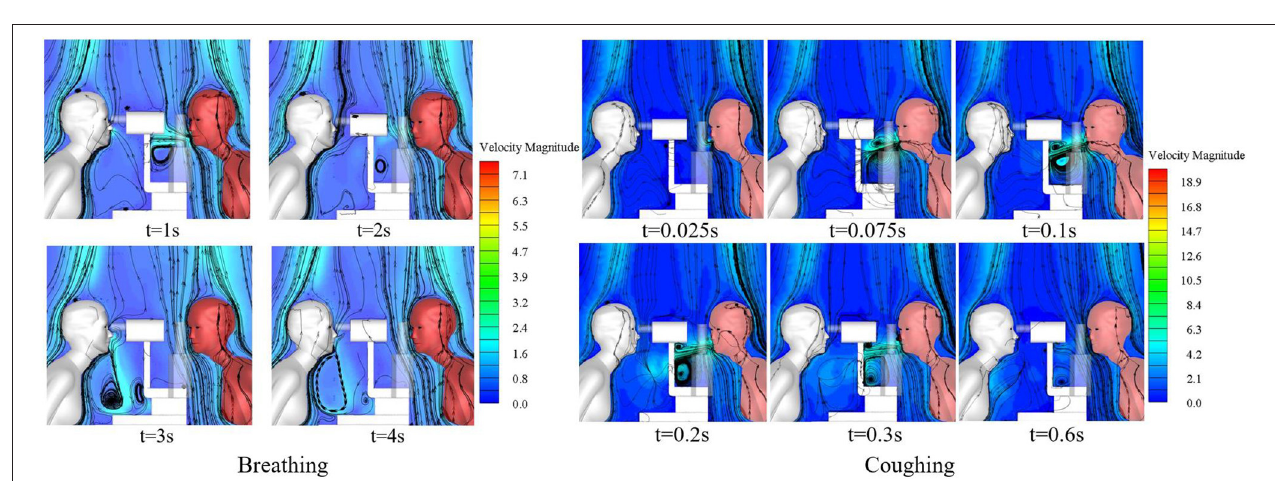
FIGURE 5 | Variation of microenvironmental airflow with